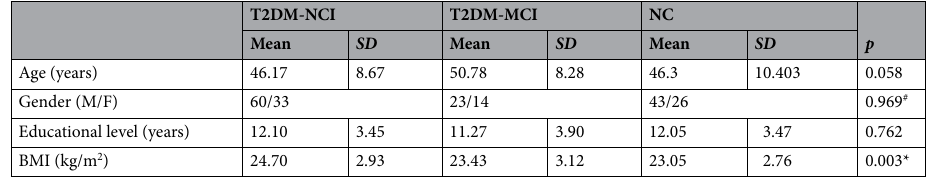
Table 1. Demographic results of T2DM-MCI, T2DM-NCI and NC groups. Data are shown as mean ± standard deviation (SD) and were analyzed using independent sample t-tests. BMI body mass index.